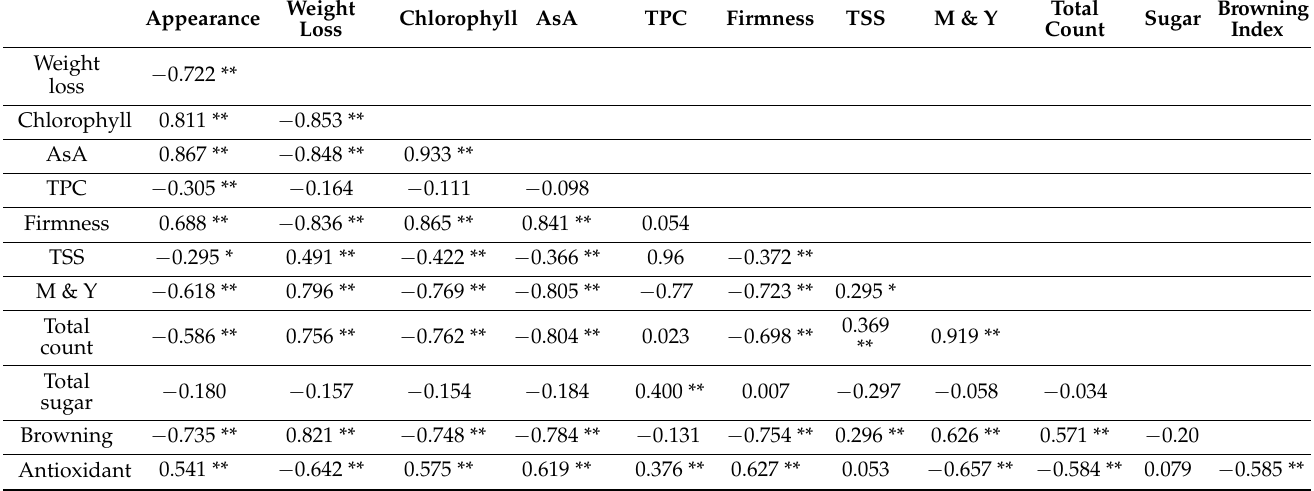
Table 2. Pearson’s correlation analysis between the physicochemical properties of fresh-cut green